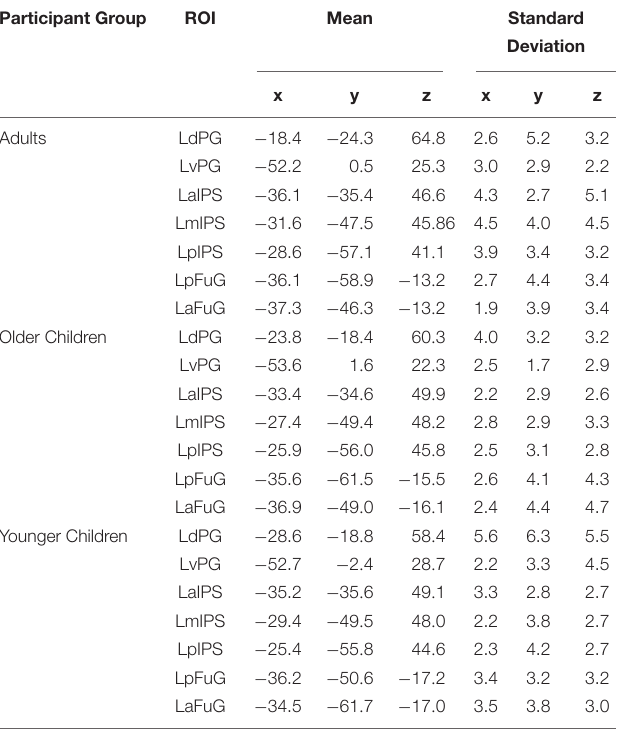
TABLE 2 | Mean and standard deviation of Talairach coordinates for